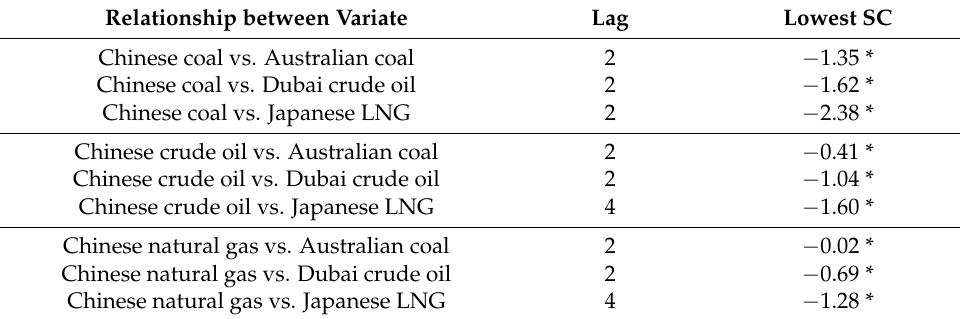
Table 2. Optimal lag